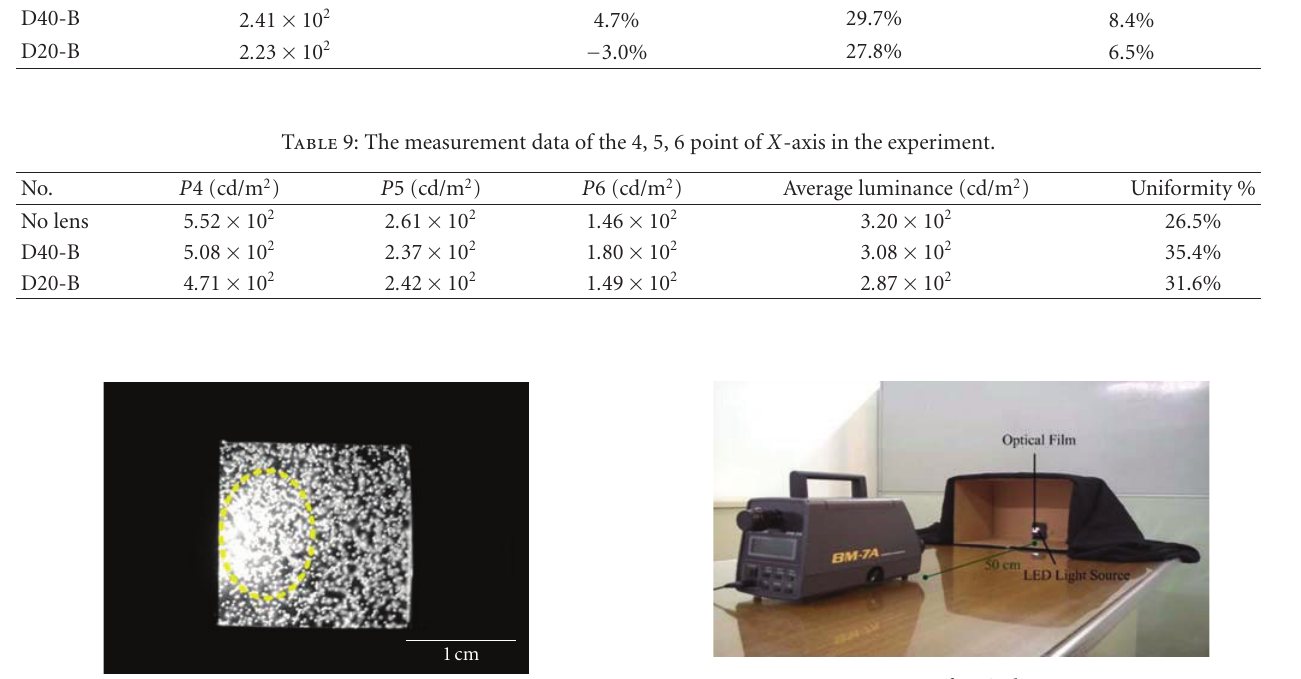
Figure 24: Set up of optical measurement.